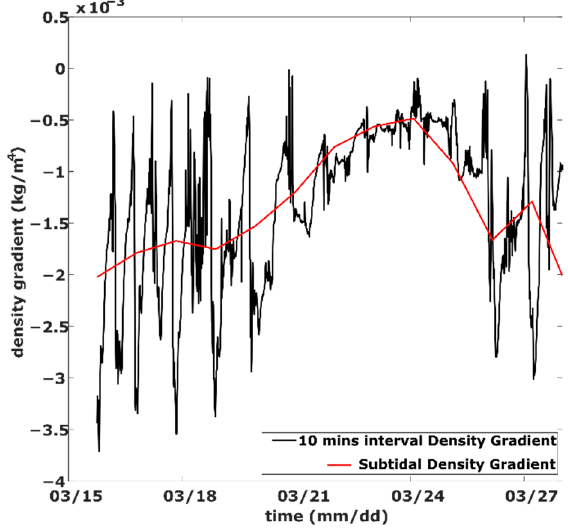
Figure 10. The longitudinal gradient of near-bottom density between Stations C and A. The red line depicts subtidal density gradient, while the black line depicts 10 min interval density gradient.